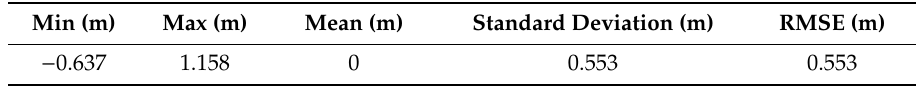
Table 7. Statistical values of the residuals for the East coordinates resulting from datum transformation UTM / ED50 to UTM / WGS84 based on a conformal